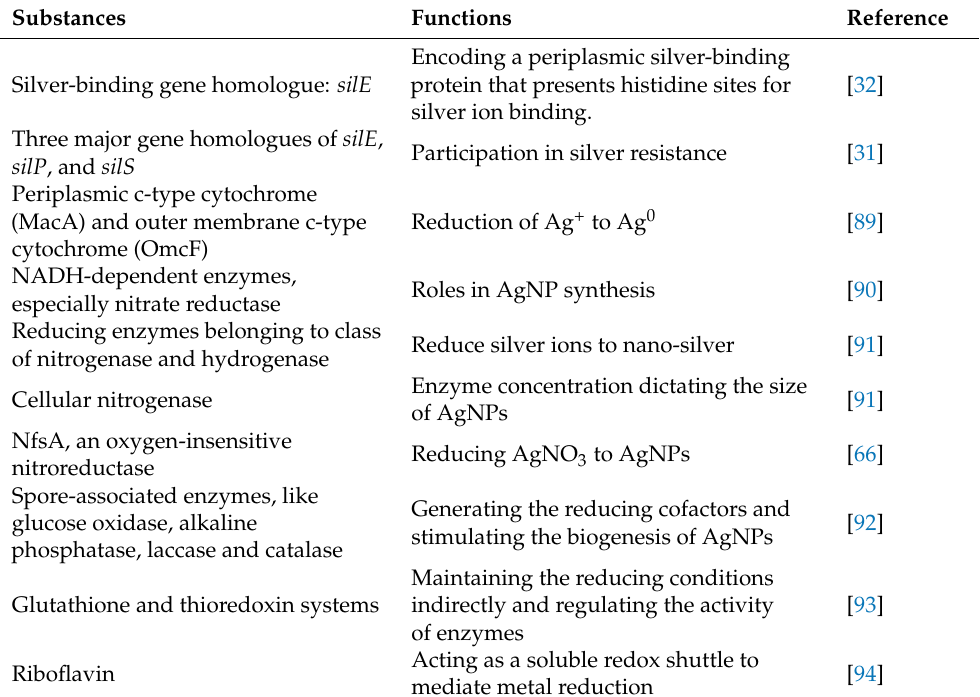
Table 3. Microbial substances that may be involved in the synthesis of silver nanomaterials. Substances Functions Reference Encoding a periplasmic Silver-binding gene homologue: silE